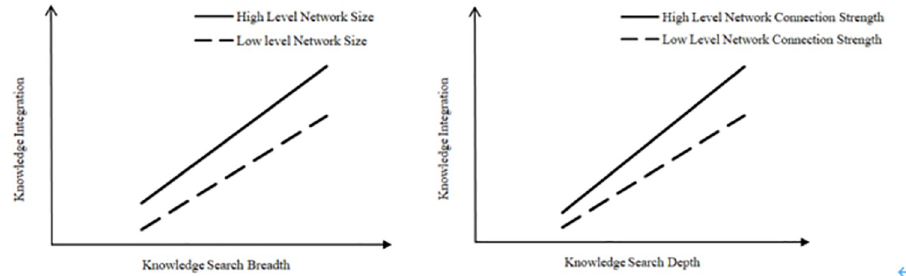
Fig 2. The moderating effect of network characteristics of innovation ecosystem.